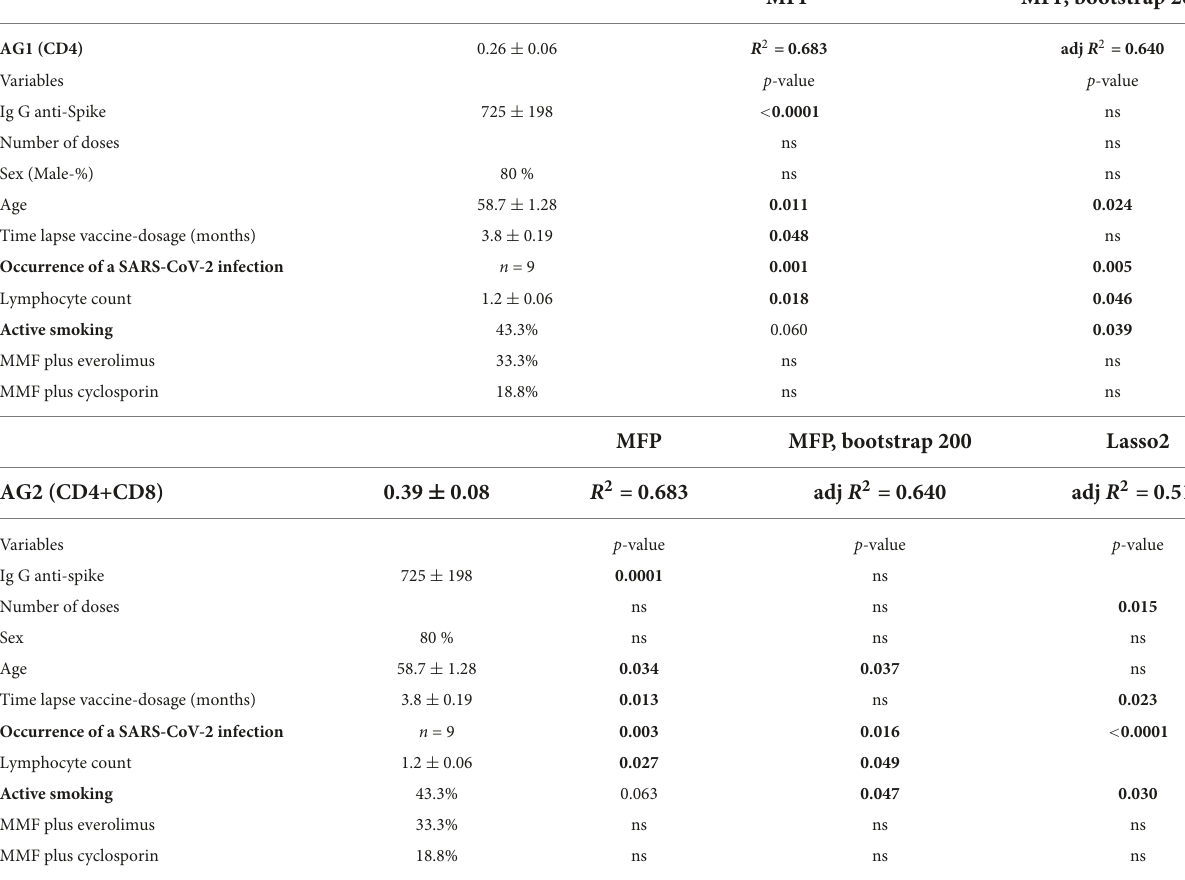
TABLE 2 Analysis of factors associated with T-cell response.